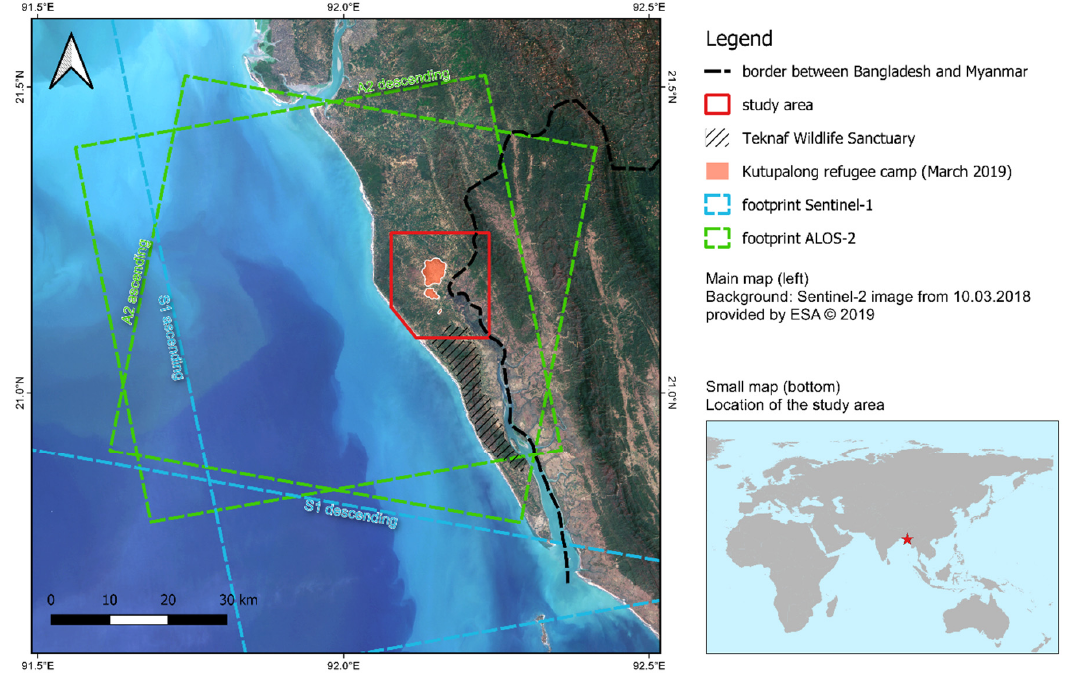
Figure 1. Map of the study area and footprints of the satellite images. ESA = European Space Agency.